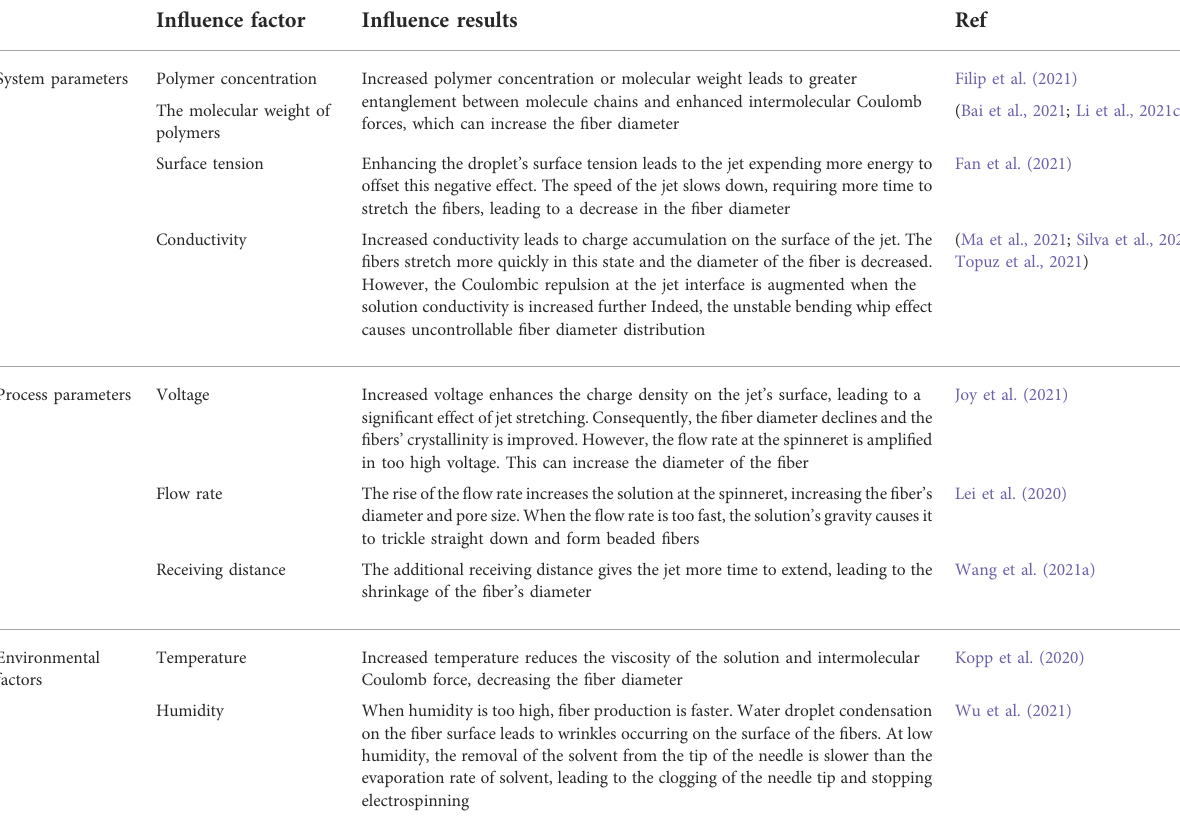
TABLE 1 Effect of different parameters on the electrospinning process (Zhang et al.,